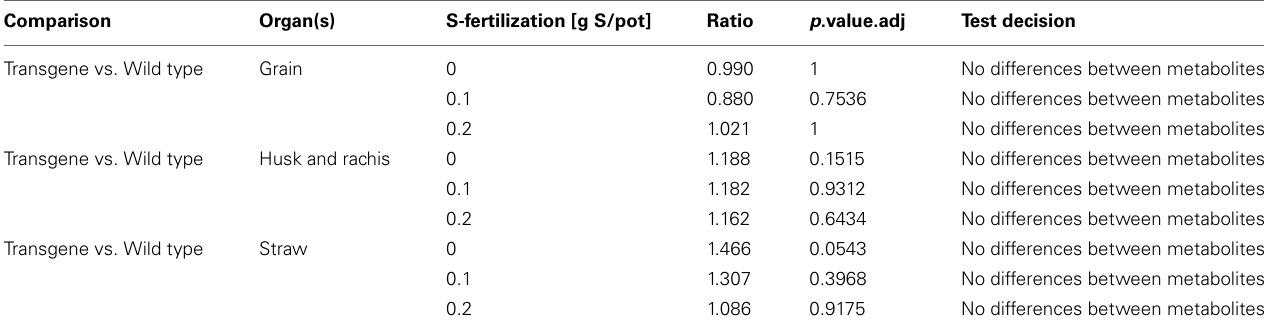
Table 1 | Testing for genotypic differences in the metabolome.